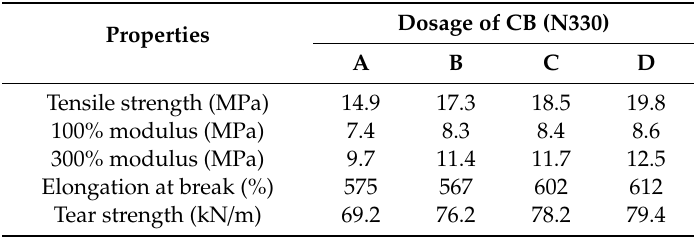
Table 3. E ff ect of CB dosage on mechanical properties of TPI / LDPE